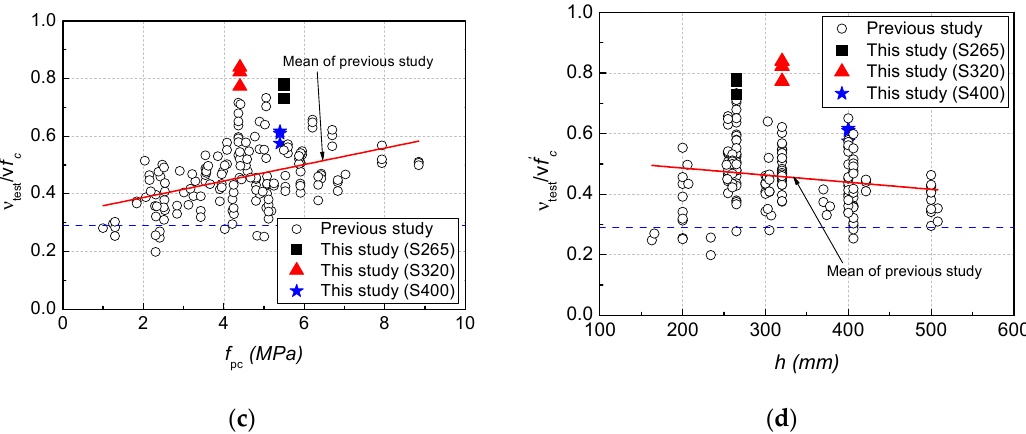
Figure 11. Analysis of key influence factors on the web-shear capacity: ( a ) Concrete compressive strength; ( b ) shear span-to-depth ratio; ( c ) Prestress introduced in centroid of section; ( d ) Height of member.